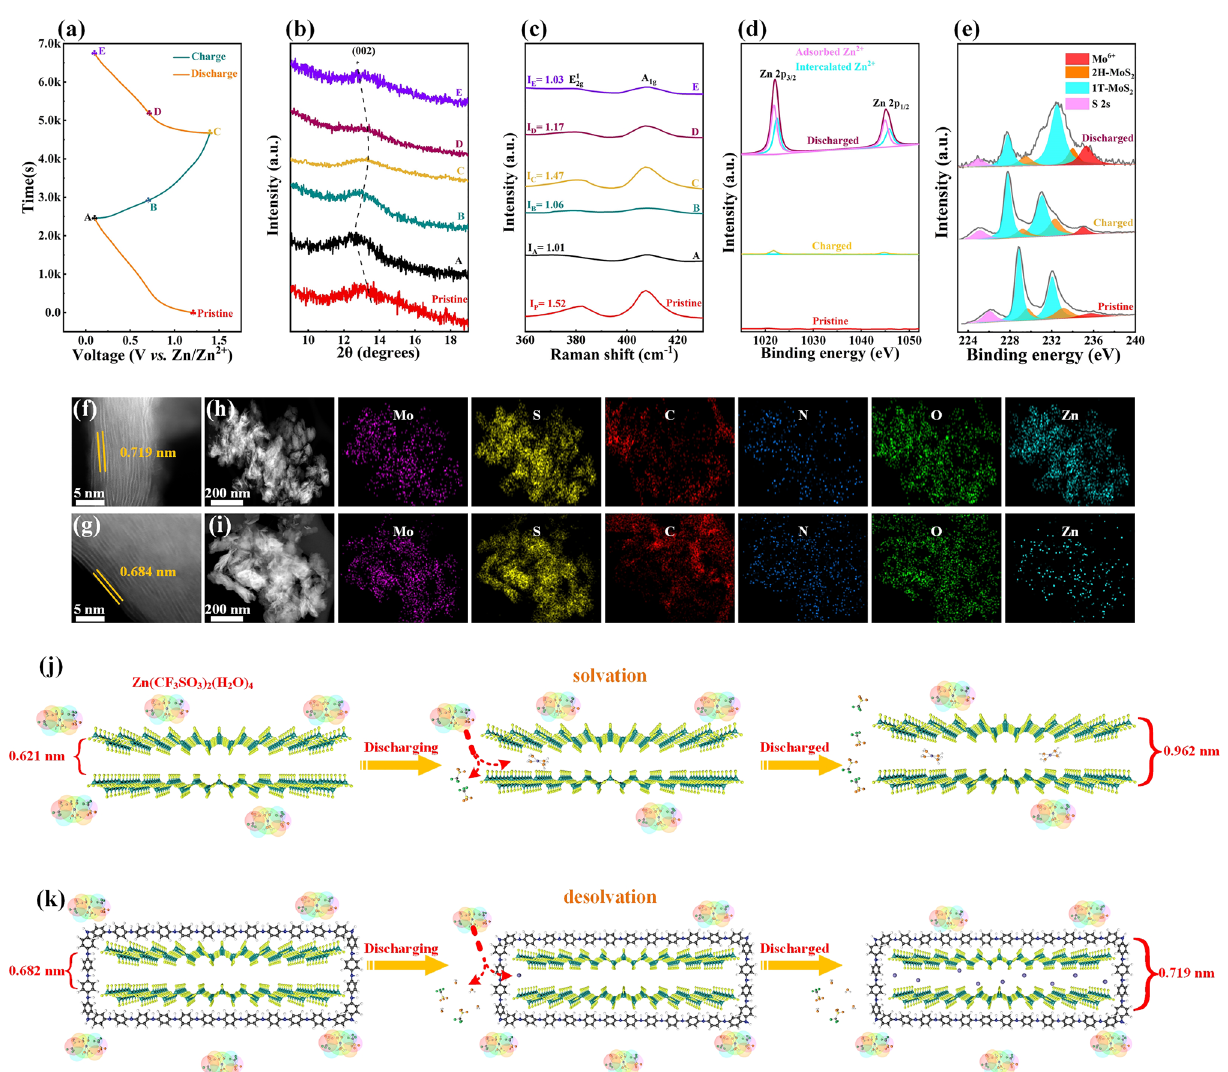
Fig. 4 Zn storage mechanism of MoS 2 /PANI cathodes. a Initial discharge/charge curve at 0.50 A g −1 , the marked states are selected for ex situ tests. Ex situ b XRD patterns, c Raman patterns, XPS spectra of d Zn and e Mo. f, g HRTEM and h, i STEM element mapping images of the fully discharged and charged MoS 2 /PANI cathodes. j, k The solvation and desolvation of MoS 2 and MoS 2